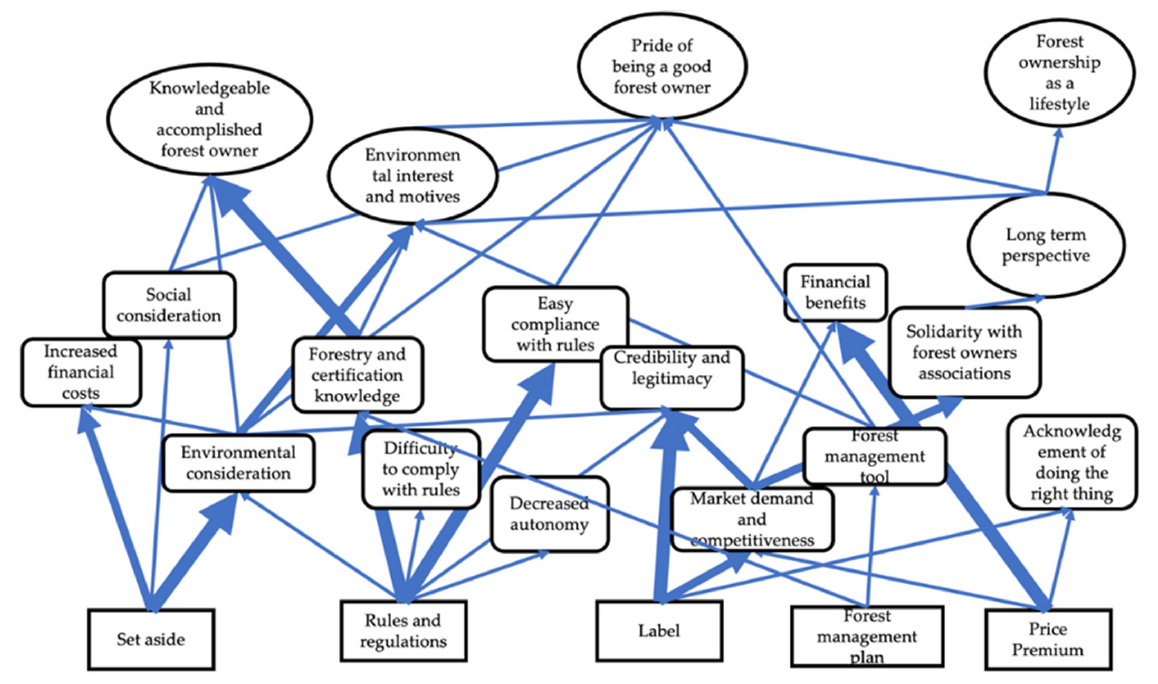
Figure A1. Hierarchical value map for all participants (N = 14).